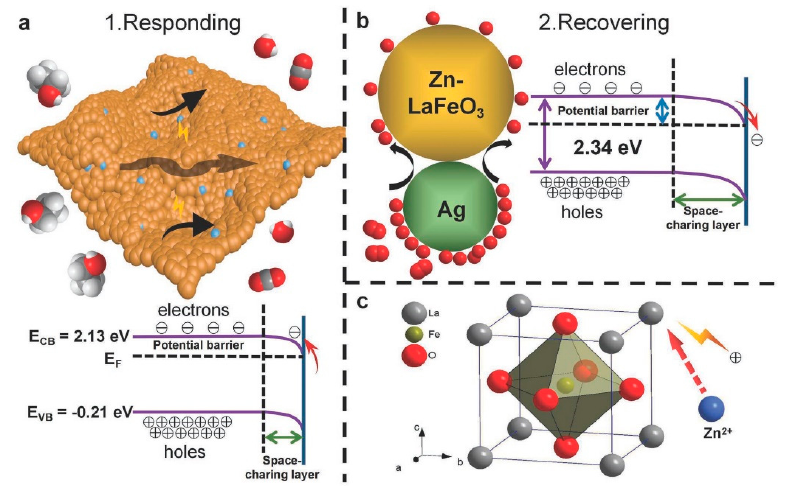
Figure 18. Schematic illustration of the sensing mechanism of the AZLFO-based sensors to ethanol: ( a ) exposed to ethanol; ( b ) exposed to air and ( c ) Zn 2+ doping in the lattice of LFO (reproduced with ( a ) exposed to ethanol; ( b ) exposed to air and ( c ) Zn 2 + doping in the lattice of LFO (reproduced with the permission from reference [176]). the permission from reference